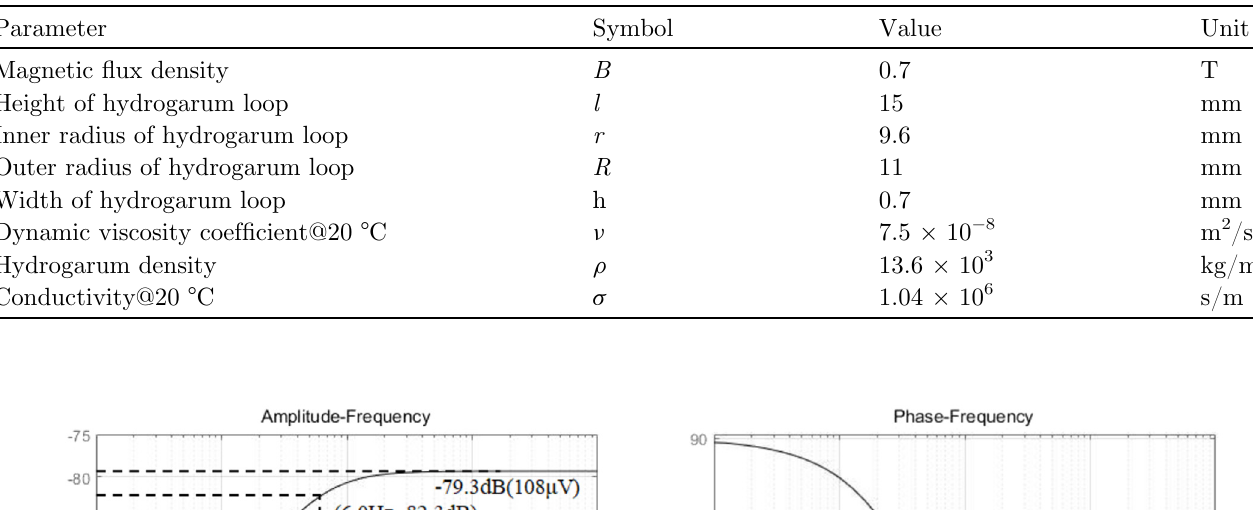
Table 1. The designed prototype ’ s parameters.